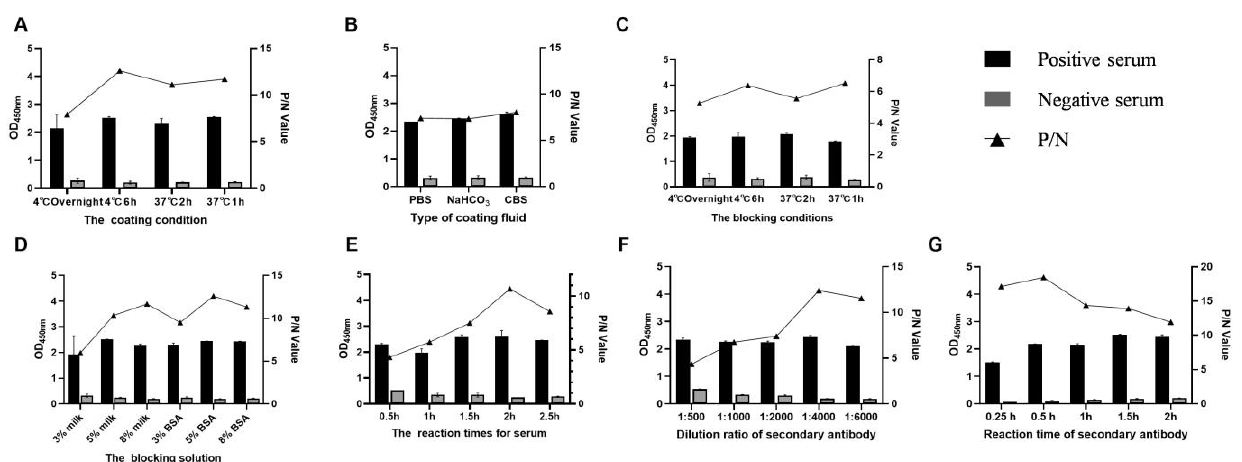
Figure 4. Optimization results for the DAgS-ELISA procedure. ( A ): Determination of optimal coat- ing conditions; ( B ): Determination of the best coating solution; ( C ): Determination of optimal block- ing conditions; ( D ): Determination of the best blocking solution; ( E ): Optimal incubation time for serum; ( F ): Optimal dilution of HRP-labeled p30 protein; ( G ): Optimal incubation time for HRP- labeled p30 protein.